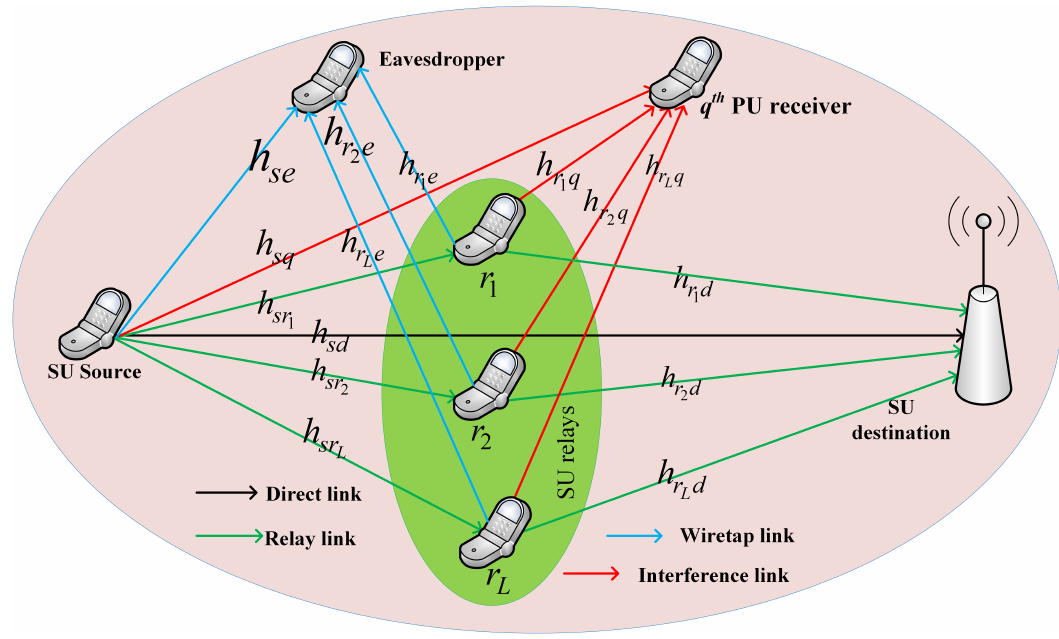
Figure 1. System